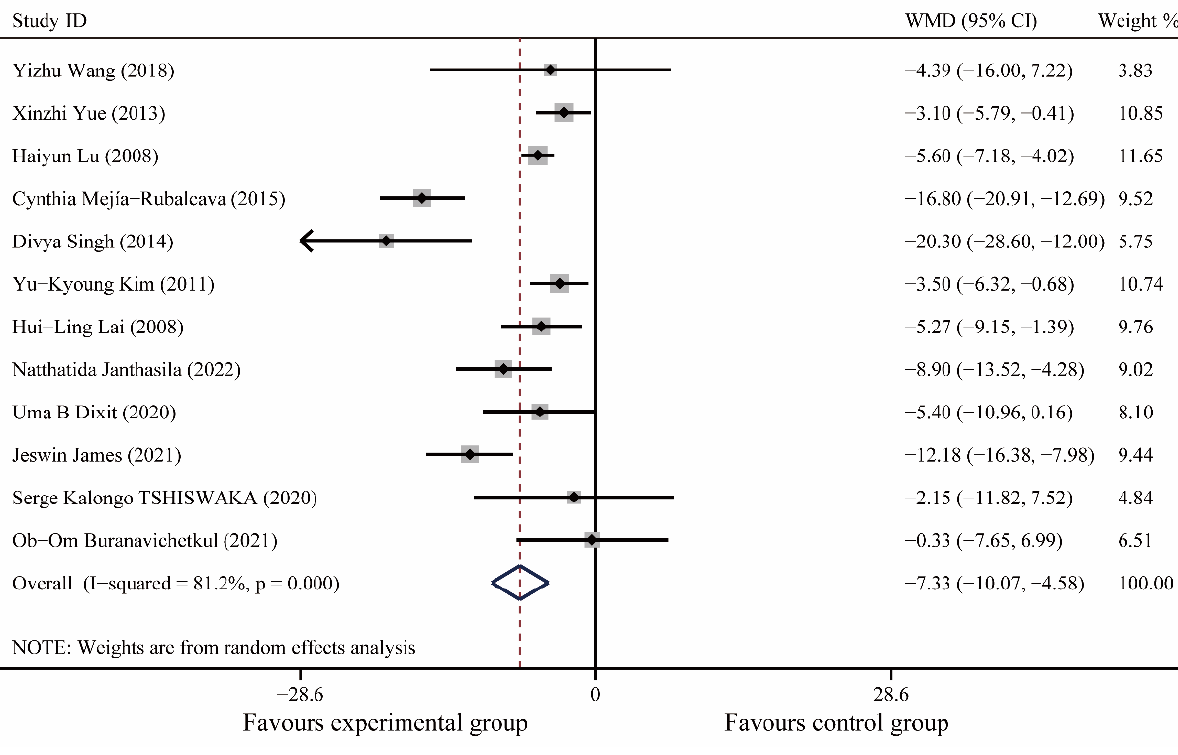
Figure 3. Forest plot of postoperative heart rate [20,21,24 – 27,29 –